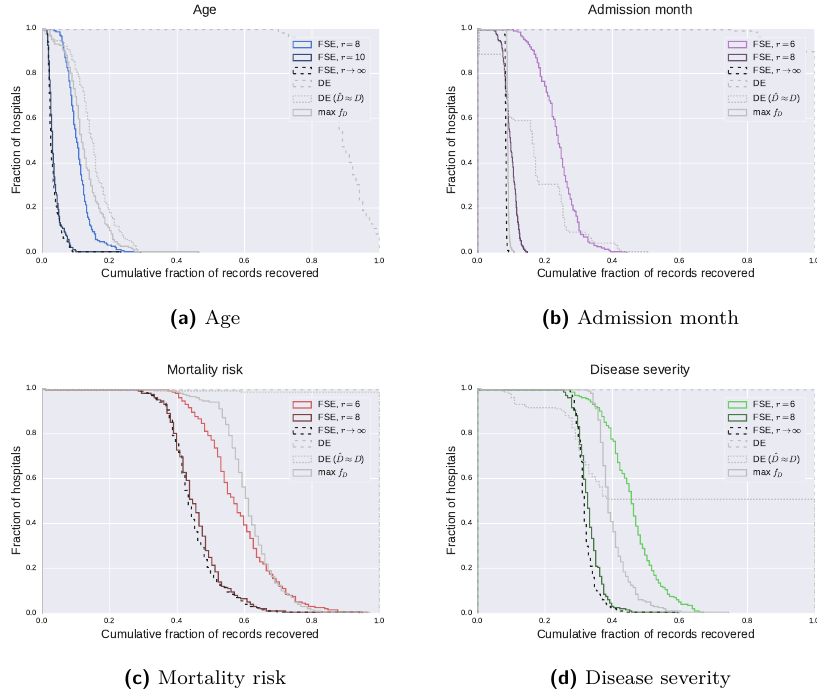
Figure 7: Our experimental results by attribute: complementary cumulative distributions (continued on next two